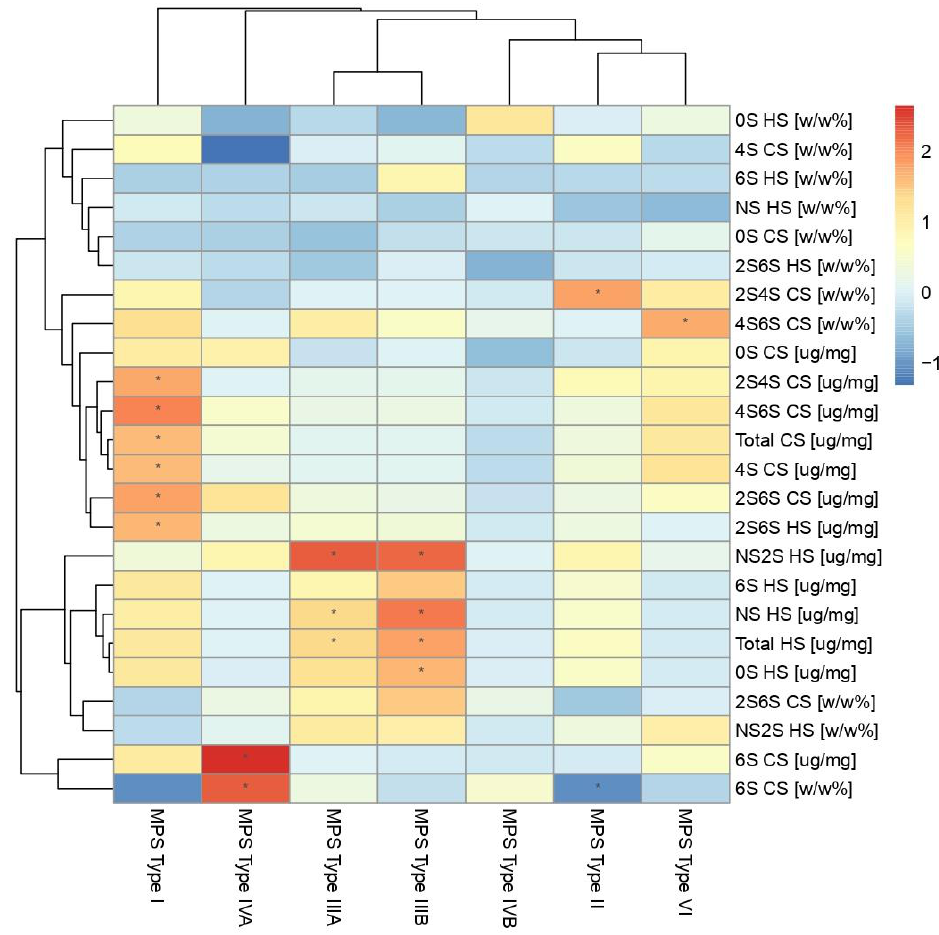
Figure 3. Heatmap of the GAGome profile across MPS subtypes compared to the control group. The color map is indicative of the standardized mean change for each GAGome measurement compared to the control group (red = increase and blue = decrease). Stars indicate statistically significant differences vs. the control group.